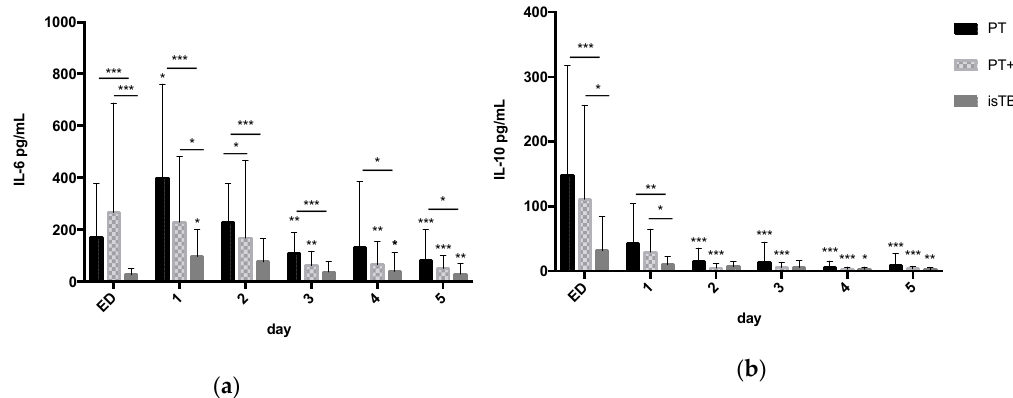
Figure 2. Inflammatory serum marker levels (mean ± Standard Deviation) over the time course from